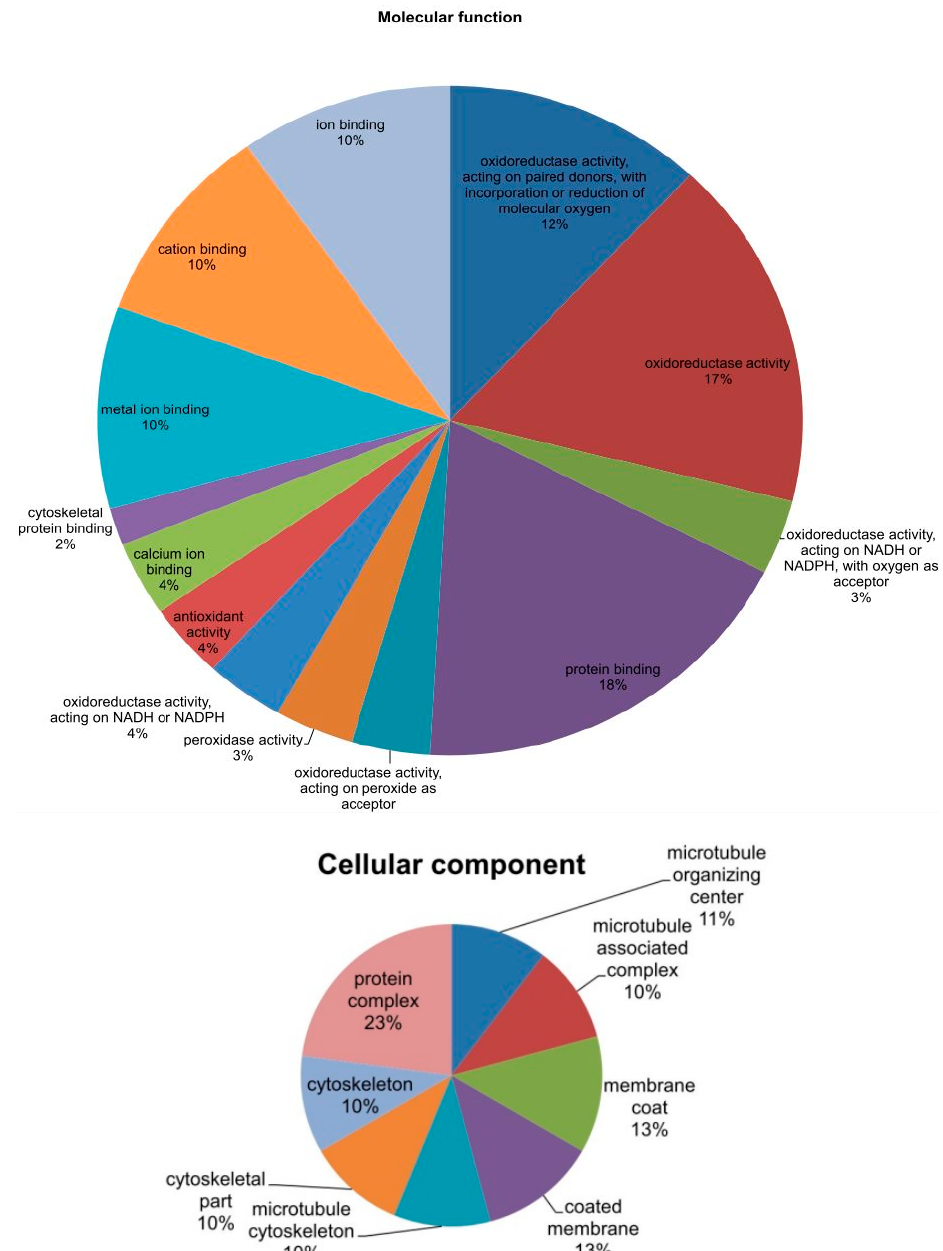
Figure 8. Genes were analyzed using the Agrigo v 2.0 software. Gene Ontology (GO) annotation results for Gossypium hirsutum mined genes. GO functional classification of genes mined with protein sequences predicted for their involvement in biological processes (BPs), molecular functions (MFs), and cellular component (CCs).